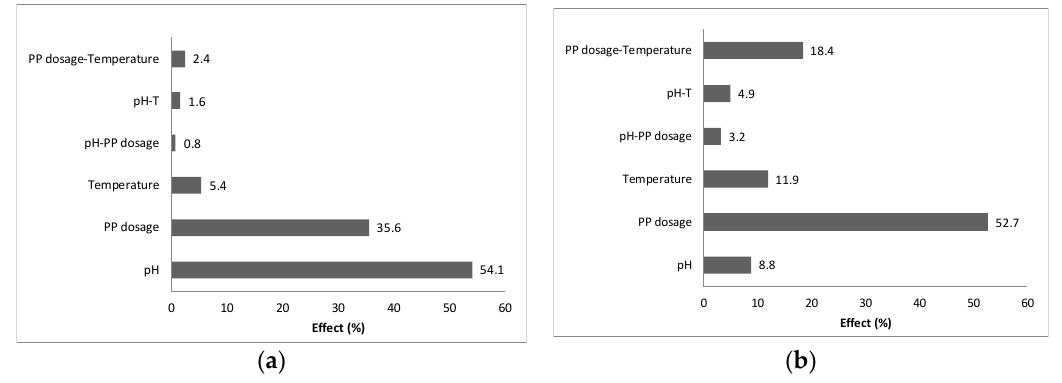
Figure 3. Pareto analysis of ( a ) Cr(VI) removal and ( b ) total Cr removal.